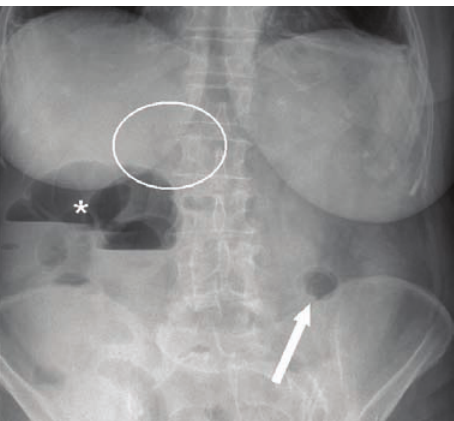
Figure 1: Plain abdominal radiograph showing Rigler’s triad (pneumobilia indicated by the circle, ectopic gallstone indicated by the arrow, and bowel distension indicated by the asterisk).